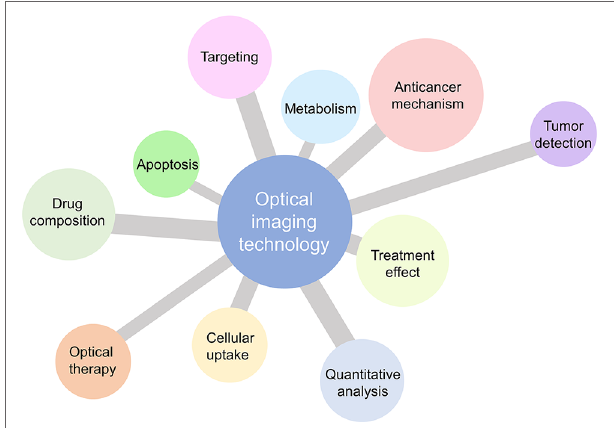
FIGURe 3 | Application potential of optical microscopic and macroscopic imaging for natural products as cancer